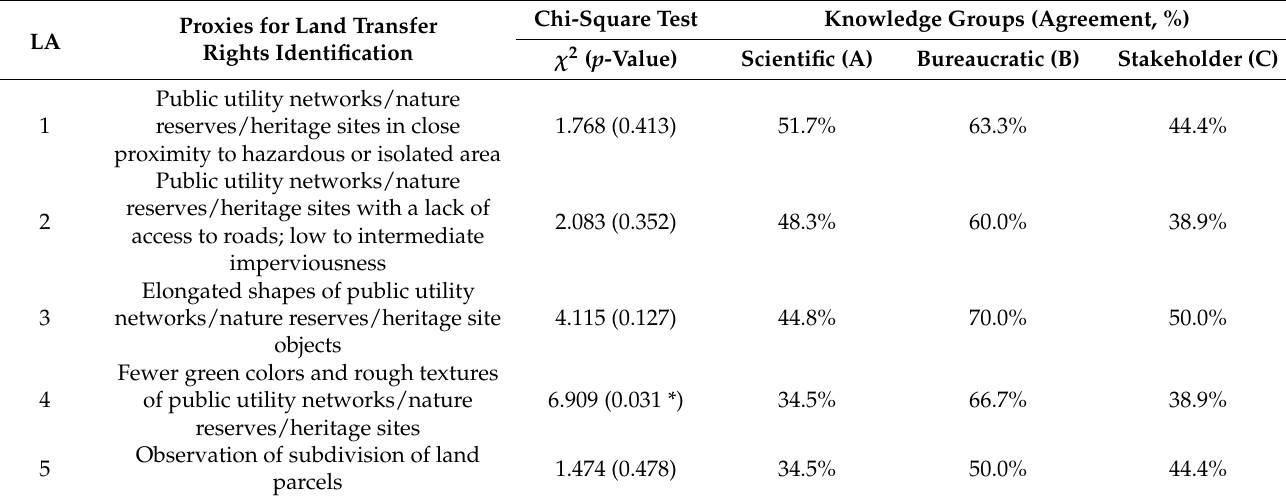
Table 5. Validating the suitability of proxies for land access rights identification and differences between knowledge groups.